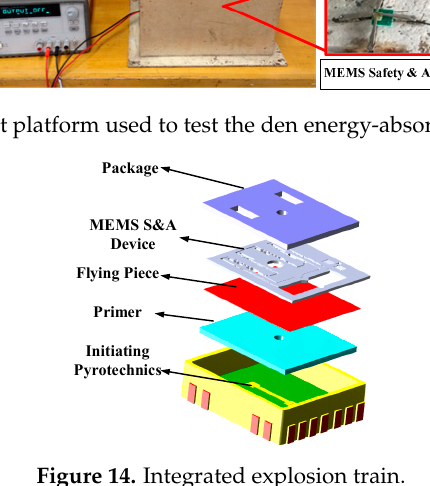
Figure 14. Integrated explosion train.